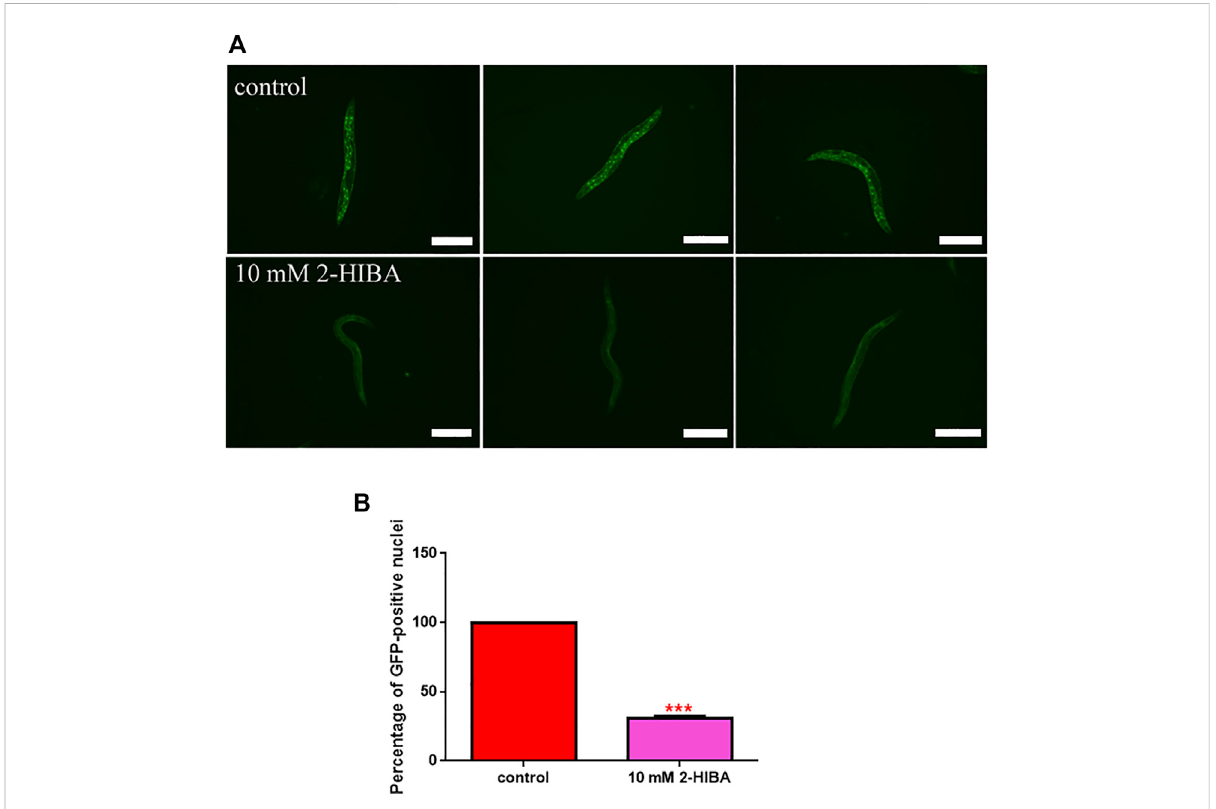
FIGURE 5 Fluorescence analysis of daf-16 ::GFP transgenic strain. (A) Effect of 10 mM 2-HIBA treatment on localization of DAF-16 protein and (B) respective Mean Fluorescence Intensity evaluation. Data were obtained from three independent experiments (60 worms for each condition). Scale bar = 100 μ m control: untreated nematodes. Statistical analysis was performed by one-way ANOVA with the Bonferroni post-test; asterisks indicate signi fi cant differences (*** p < 0.001). Bars represent the mean of three independent